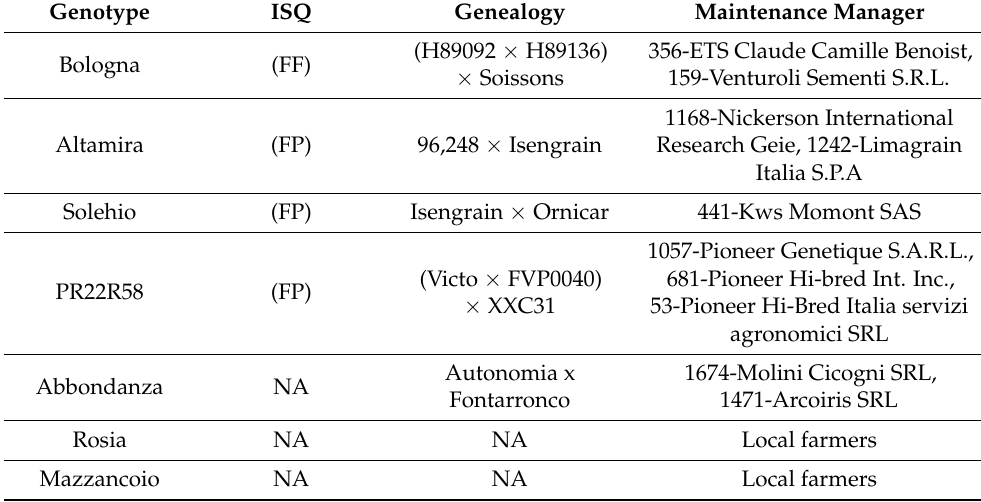
Table 1. Characteristics of the wheat selected for the